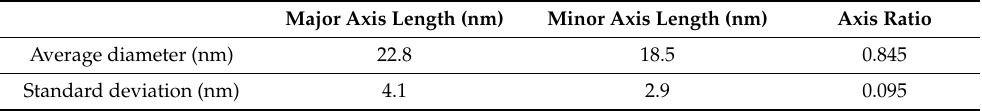
Table 1. Characterization of the particle size and homogeneity of the obtained preparation of gold nanoparticles.